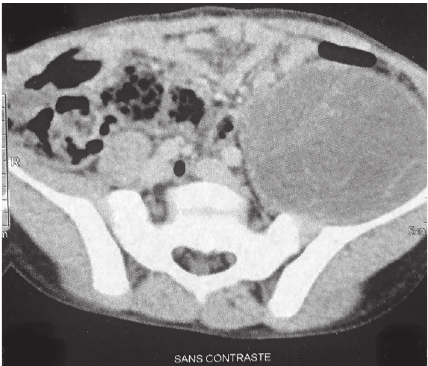
Figure 1: CT scan showing a well-limited hydatid cyst in the expansion of left psoas